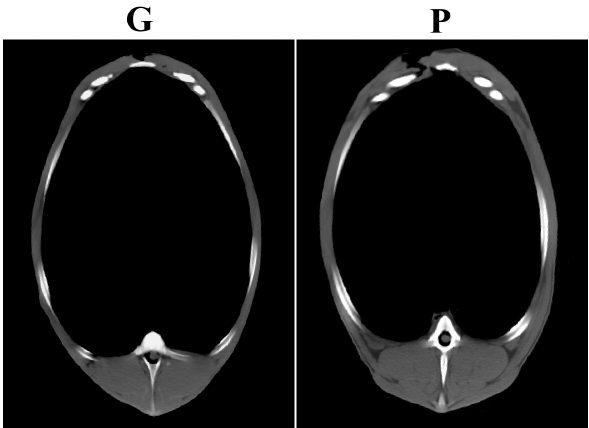
Figure 1. Cross sectional CT scan at identical anatomical location (at the joint of the sixth and seventh thoracal vertebrae) of two ani- mals, one from group G (monocotyledonous grass pasture) and one from group P (pure papilionaceous